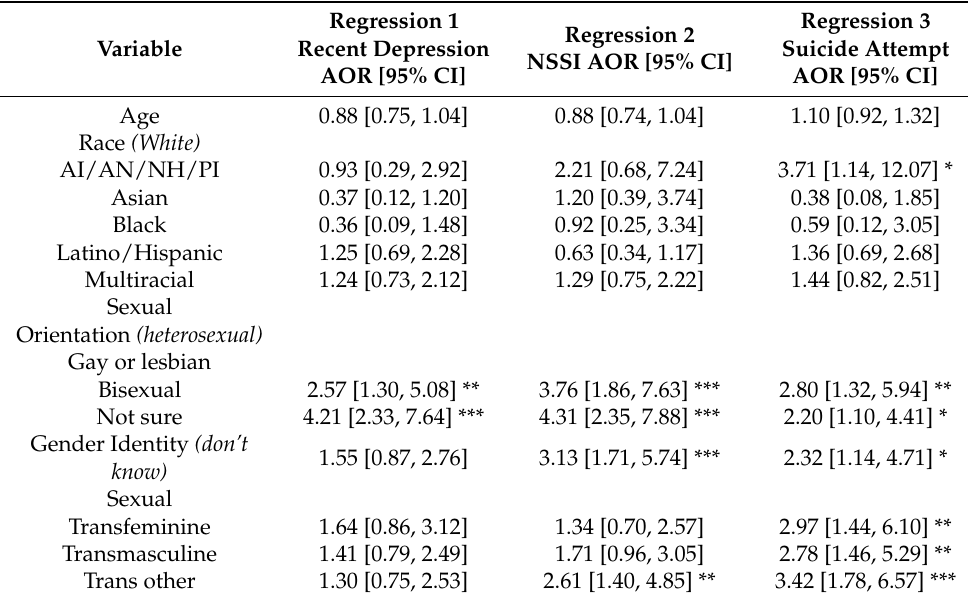
Table 2. Logistic Regression Models for Predicting Mental Health among TGD ( N =